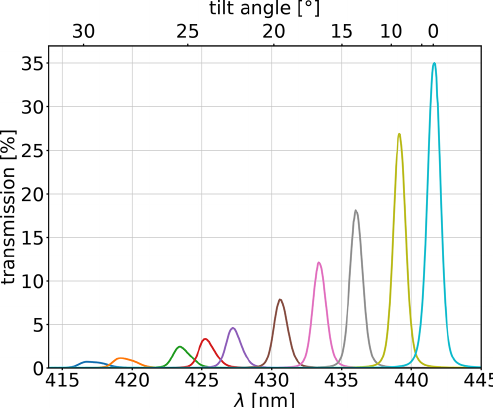
Figure 1. Tilt angle sensitivity of transmission characteristics of interference band-pass filter with 441.6nm nominal centre wave- length. Measured transmission curves are shown for tilt angles from 0 ◦ (orthogonal, 441.6nm centre wavelength) to 30 ◦